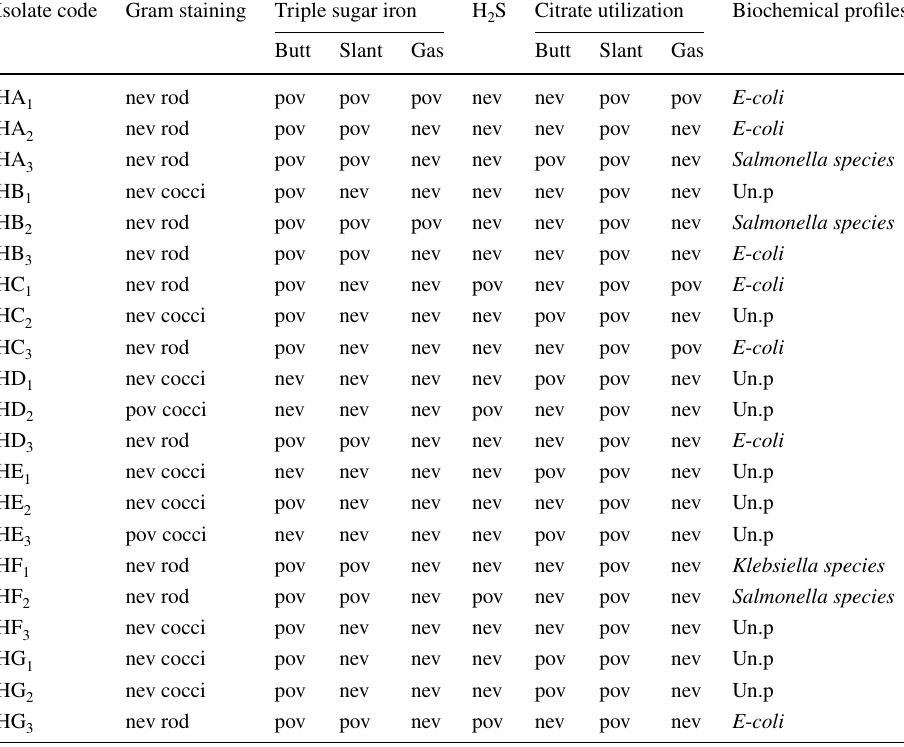
Table 3 The preliminary identification assay findings for presumptive coliform microorganism isolates with membrane-fecal coliforms agar and biochemical